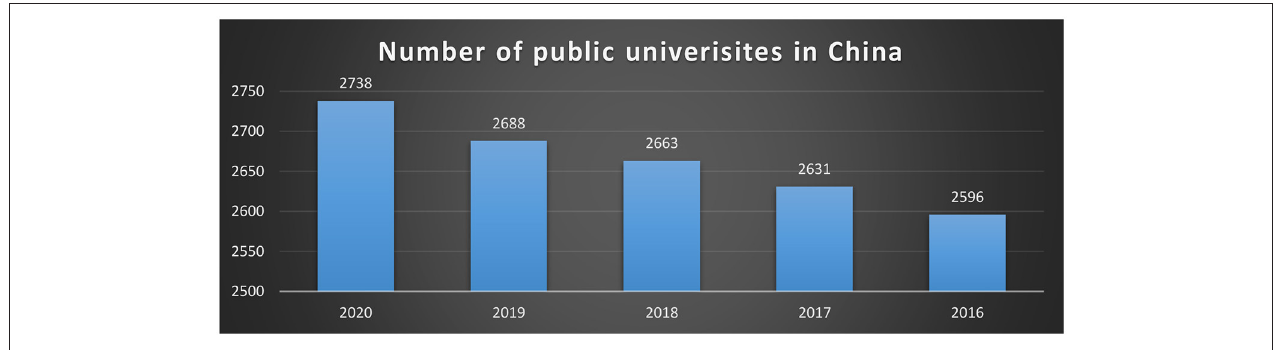
FIGURE 1 | Number of public universities in